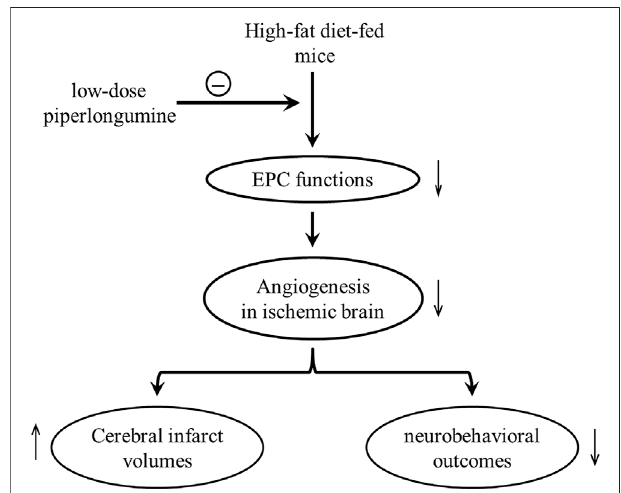
FIGURE 7 | Putative mechanisms underlying low-dose piperlongumine reducing cerebral ischemic injury in HFD-fed mice. High-fat diet impaired endothelial progenitor cell function, decreased the ischemic angiogenesis, increased cerebral infarct volumes, and reduced the corresponding neurobehavioral outcomes in mice. Low-dose piperlongumine reduces cerebral ischemic injury via rescuing impaired EPC-mediated angiogenesis in HFD-fed